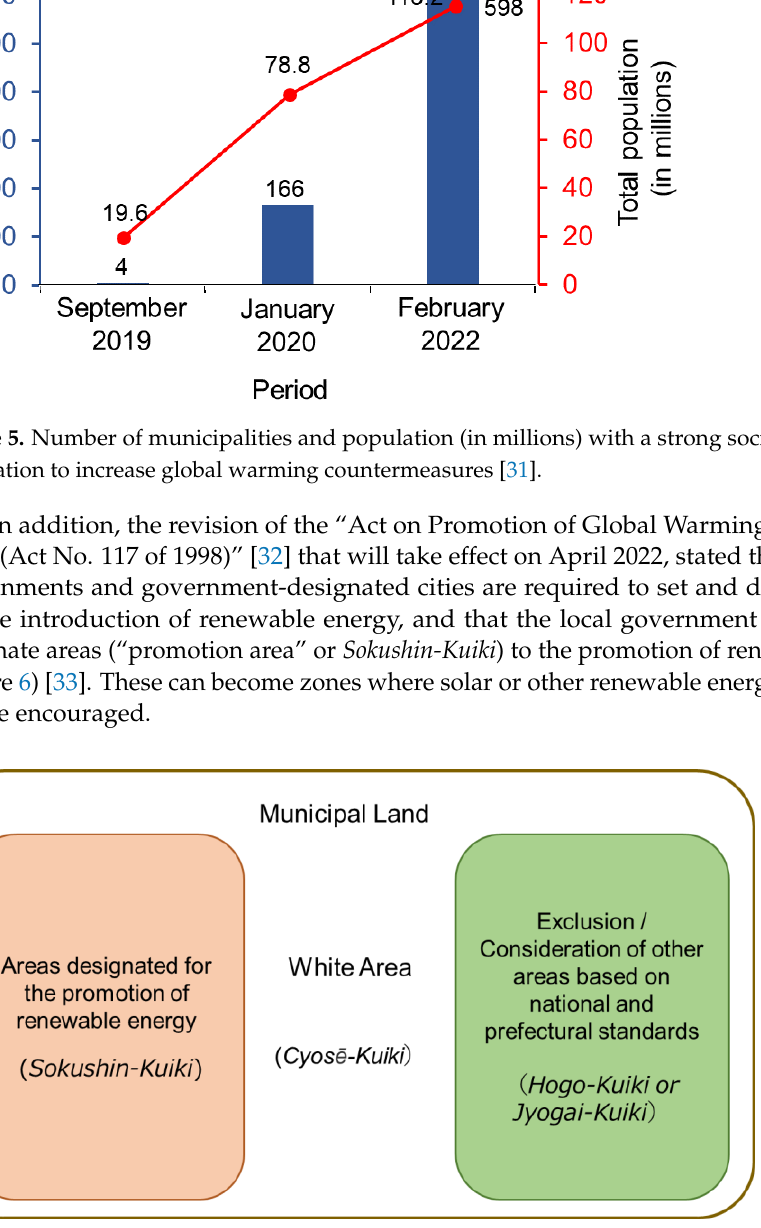
Figure 6. Local governments designate “promotion areas” or Sokushin-Kuiki for renewable energy sites [33].